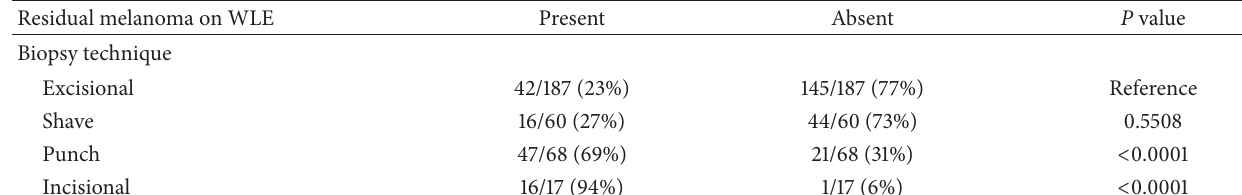
Table 3: Frequency of residual melanoma on wide local excision by biopsy technique.